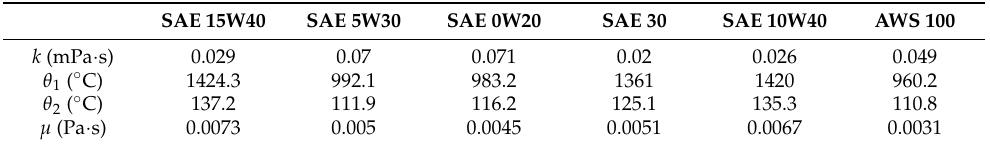
Table 1. Input parameters of the Vogel equation and the dynamic viscosities at temperature of 120 ◦ C. SAE